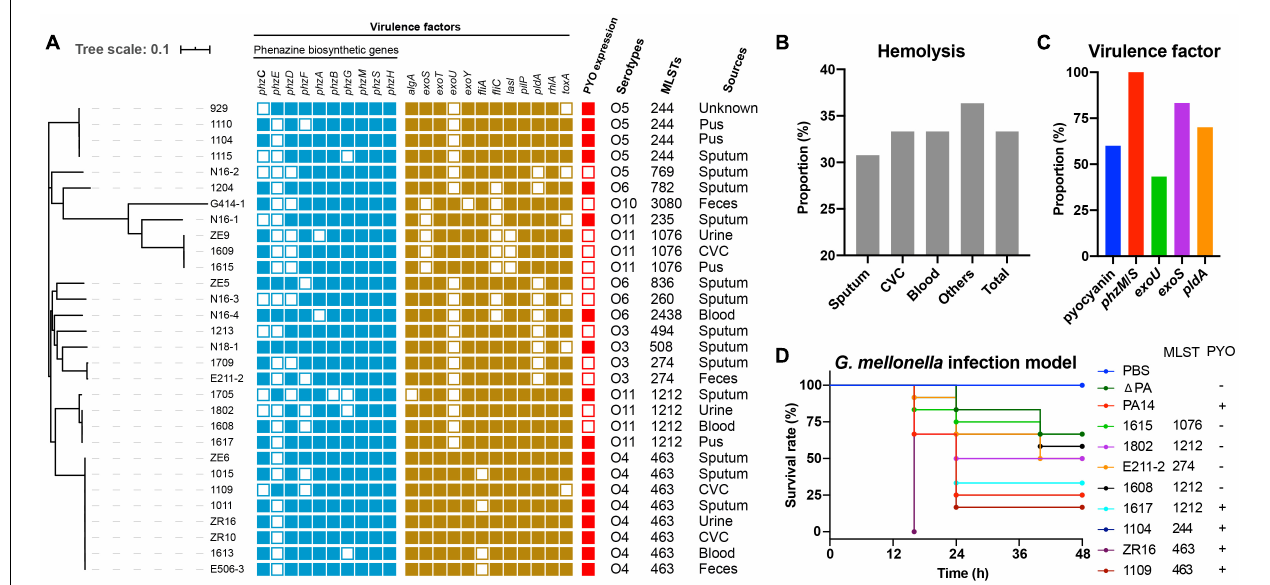
FIGURE 2 | Assessment of the potential toxicity of P. aeruginosa isolates. (A) Phylogenetic tree and characteristics of all isolates. CVC, Central Venous Catheter; (B) Hemolysis proportion of different sampling sources. (C) The proportion of antimicrobial resistance-associated virulence factors, such as biosynthetic genes, exoU , exoS , pldA ; and pyocyanin expression. (D) Larval survival rates in the G. mellonella infection model. Each isolate was challenged with 12 larvae for 48 h, with three biological replicates.